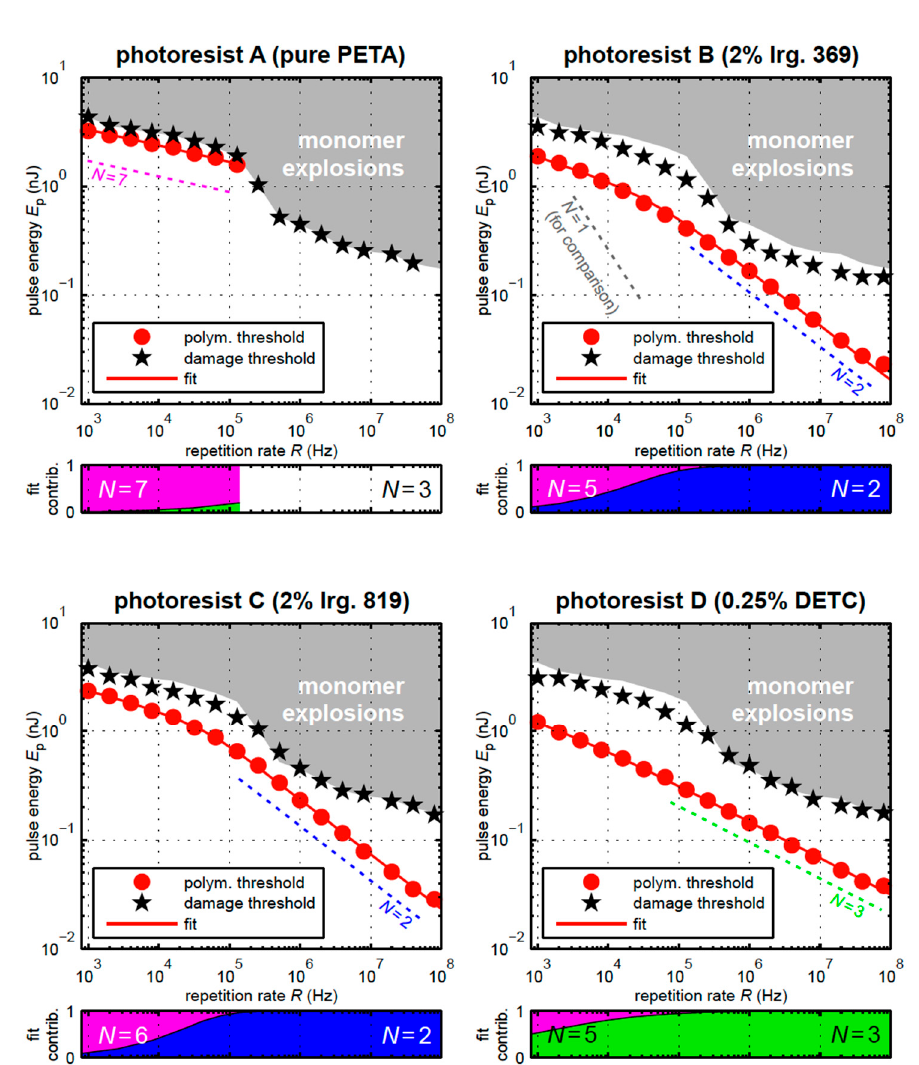
Figure 2. Graphs showing the minimum pulse energy necessary to cause polymerizations (red circles) and uncontrolled polymerizations (black stars) as a function of repetition rate for four different photoresists ( A – D ). Under each graph is another graph indicating the magnitude of the weighting factors, such as a 2 or a 5 , to the curve fitting in the dashed line above as a function of frequency. Reproduced from [22].